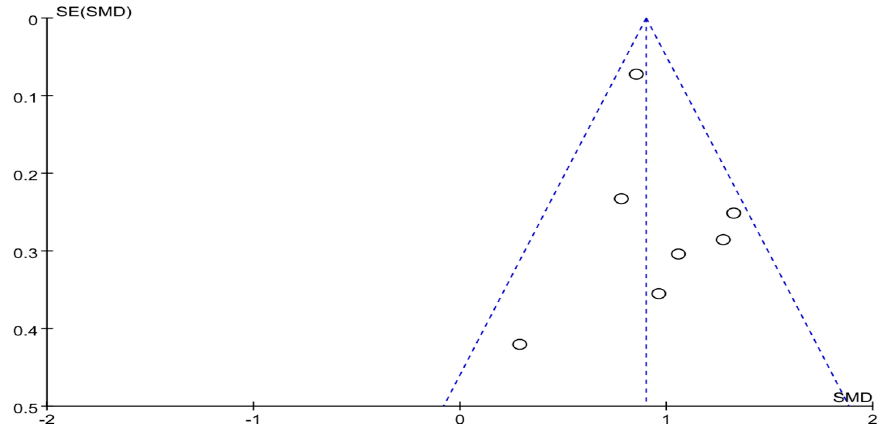
Figure 8. Funnel plot for publication bias of social comfort.